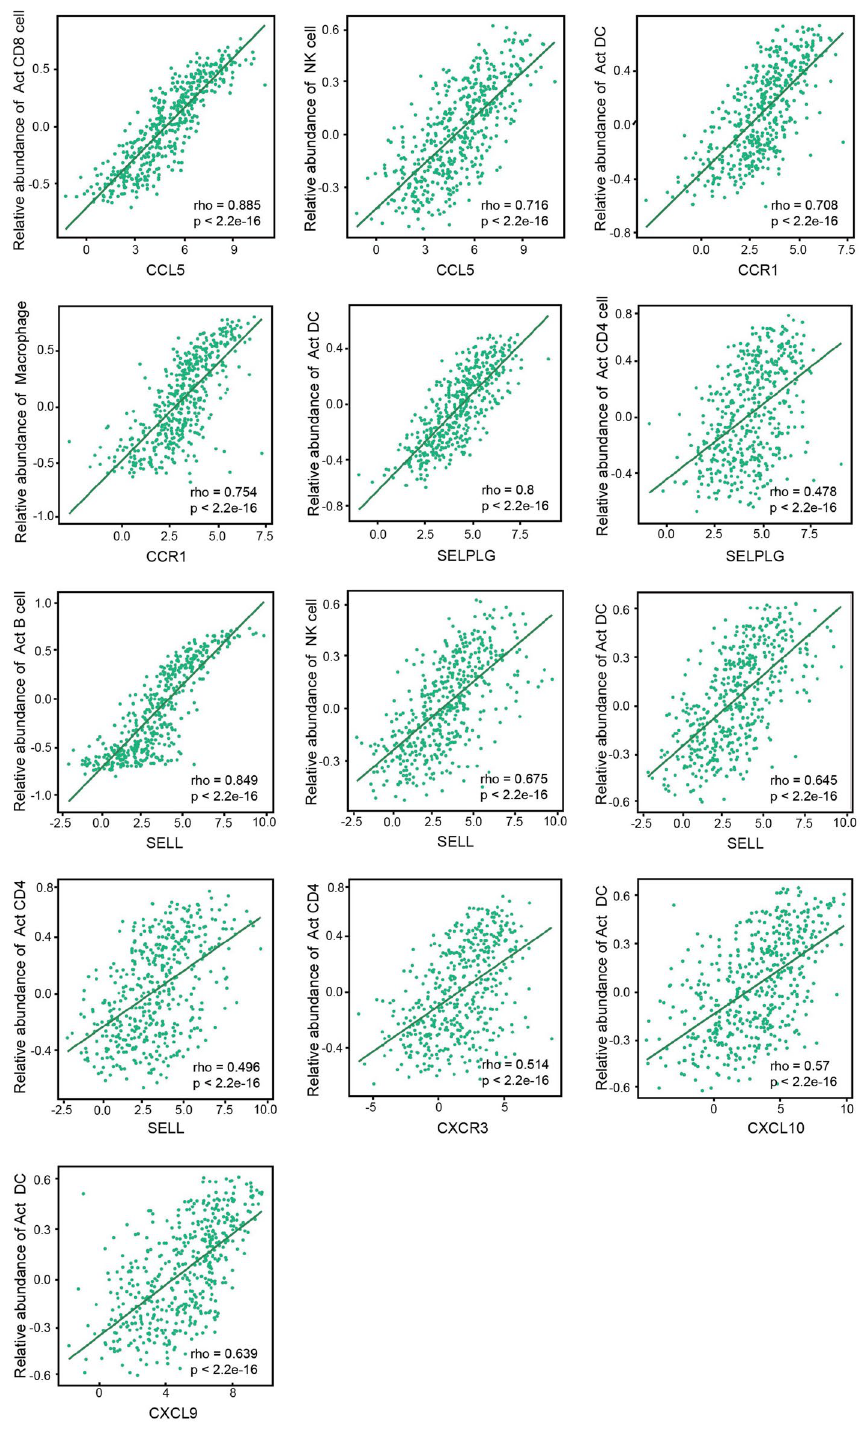
Figure 9. Associations of the CCL5, CCR1, SELPLG, SELL, CXCR3, CXCL10, CXCL9 expression level with immune cells in SKCM from TISIDB